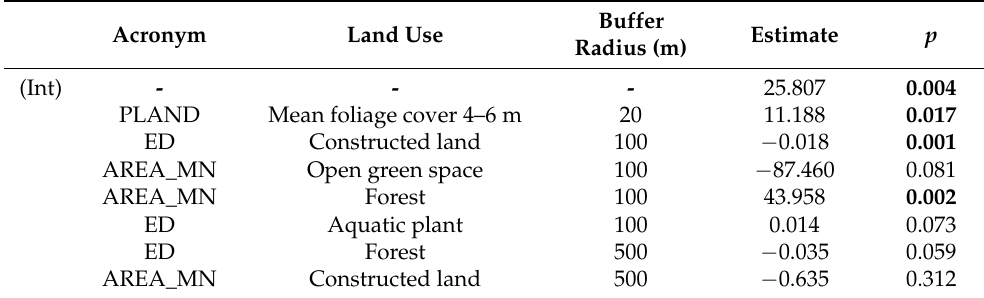
Table 3. Results of model averaging for bird species richness for the top models (Table 2). The definitions of predictors are listed in Table 1. p values < 0.05 are in bold font.